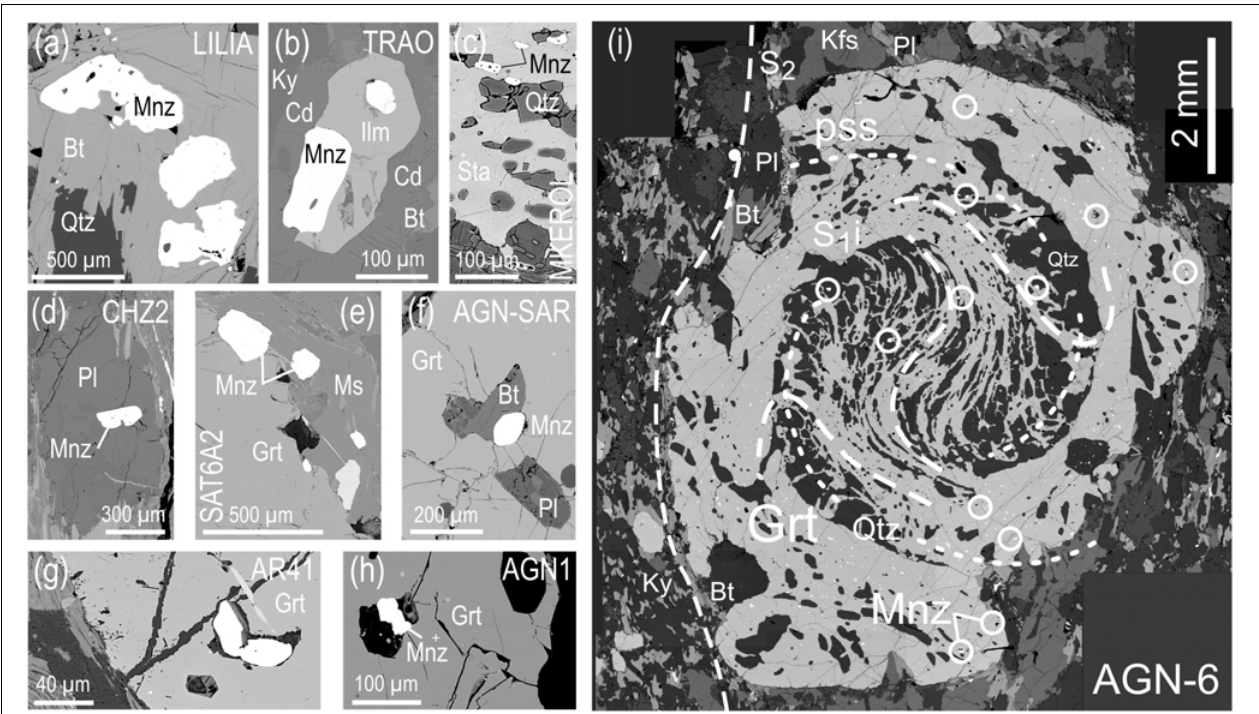
FIGURE 11 | Monazite as inclusions in other minerals. (a) Huge anhedral monazite enclosed in biotite in a migmatite from Lilia, Léon Domain (Schulz et al., 2007). (b) Inclusion in ilmenite (Ilm) in a cordierite (Cd) garnet gneiss, Léon Domain. (c) Inclusion in staurolite in micaschist from Central Brittany (Schulz, 2013). (d) Inclusion in plagioclase in garnet gneiss from the Lower Gneiss Unit, Haut Allier, French Massif Central (Schulz, 2014). (e) Garnet in a UHP gneiss from Central Erzgebirge partly encloses monazite of Carboniferous age in its rim. (f) Monazite with biotite in garnet in a kyanite garnet gneiss from the Upper Gneiss Unit, French Massif Central. (g , h) Cracks in the garnet connect monazite inclusions with the matrix. (i) Example of a syntectonic helicitic garnet with S-shaped internal foliation (S1i) and double pressure shadow inclusion spiral (pss) enclosing numerous monazites (marked by rings). Detailed analysis of yttrium contents in monazite and garnet suggest that the Carboniferous monazites crystallized at the same time or later as the garnet (Schulz,